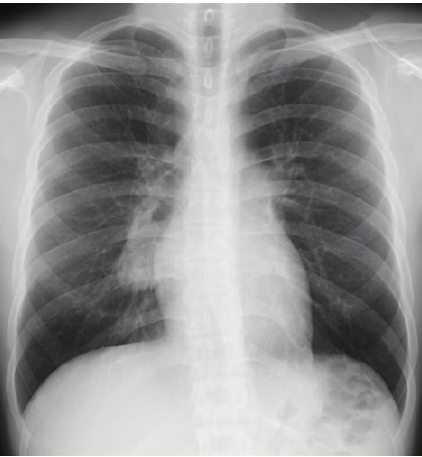
Figure 1: Chest radiograph shows a mass lesion located in the right infrahilar